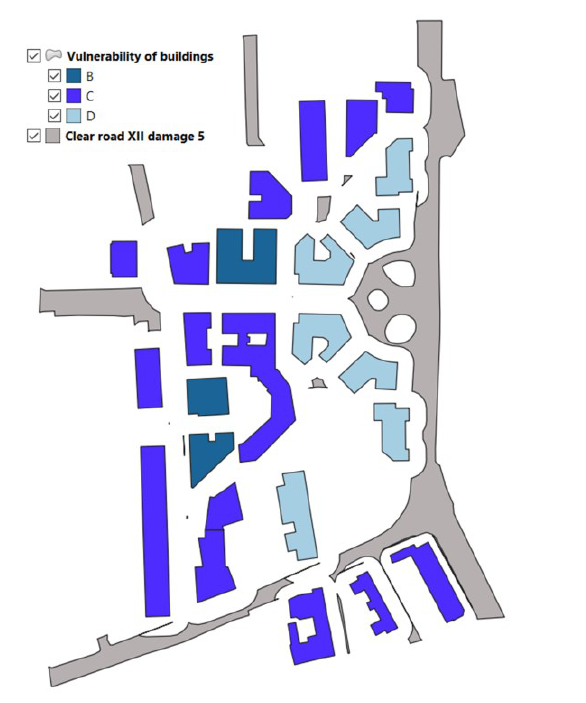
Figure 10. The scenario for intensity degree XI (Damages below 4 are not considered).